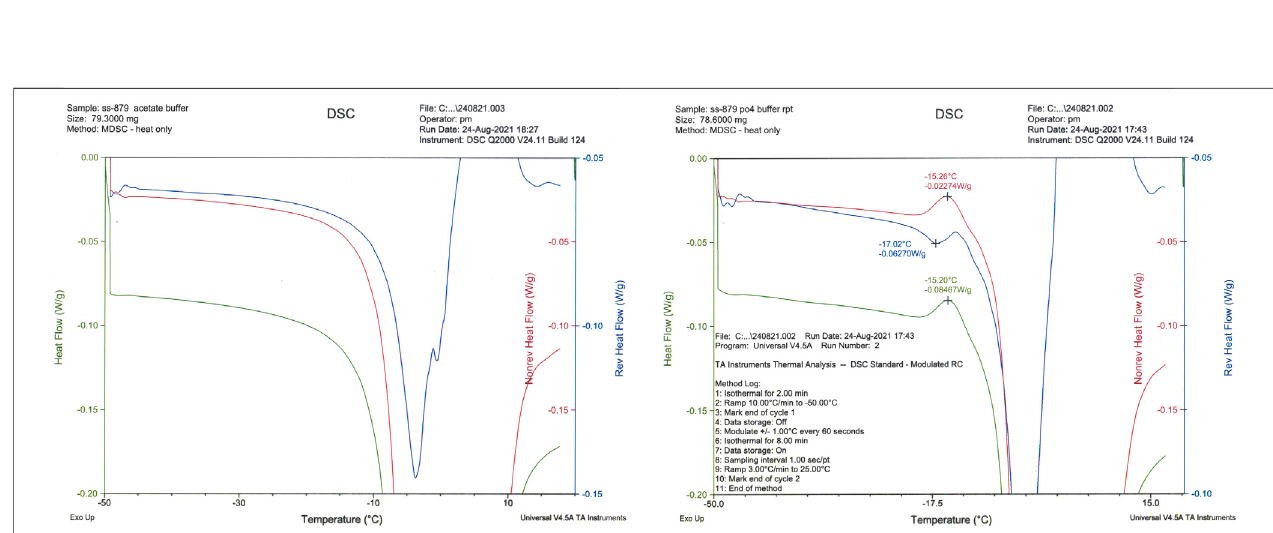
FIGURE 5 | mDSC traces of sodium acetate (LHS) and sodium phosphate (RHS) formulations SS-879.